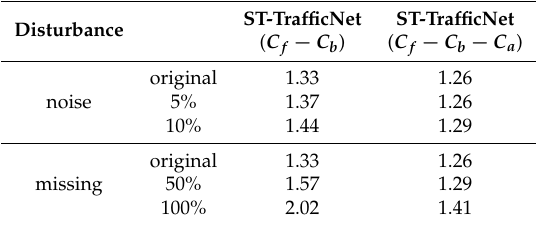
Table 5. The Mean Absolute Error (MAE) score of ST-TrafficNet with or without attentive diffusion convolution on missing and incorrect graph structure. Under the condition of incorrect graph structure with 5% noise, the proposed model remains nearly the same while the non-attentive model degenerates by 3%. Under the condition of unavailable predetermined graph structure (i.e., missing rate 100%), the non-attentive model dropped by 51.9% and the proposed model only degenerates by